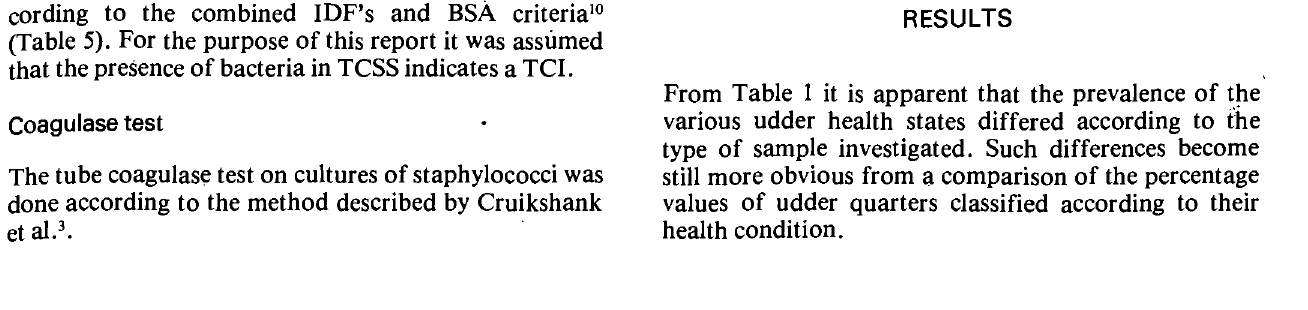
Table 2: The status of 10 of the 99 quarters (Table 1) according to the International Dairy Federation's (IOF) criteria alone, IOF criteria with due regard to the diameter of the bovine serum albumin (BSA) precipitation zones and lastly the IOF criteria (only the somatic cell count (SeC)) with due regard to the bacteriological results of the teat canal swab sample (TeSS)